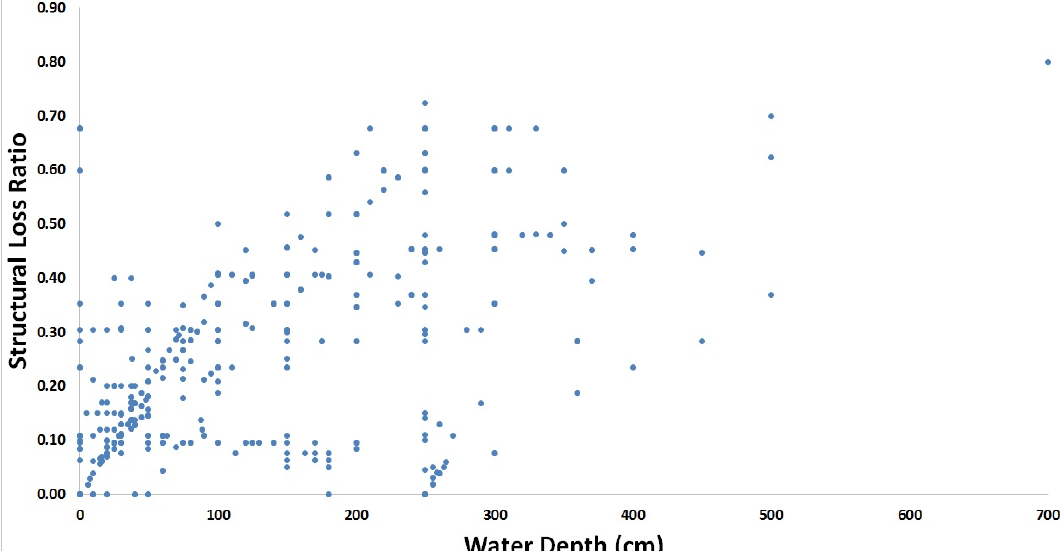
Figure 7. Scatter plot showing the relation between loss ratio and water depth (structural loss ratio does not cover the damages of mobile contents, and it is only limited to all building fabrics including stationary